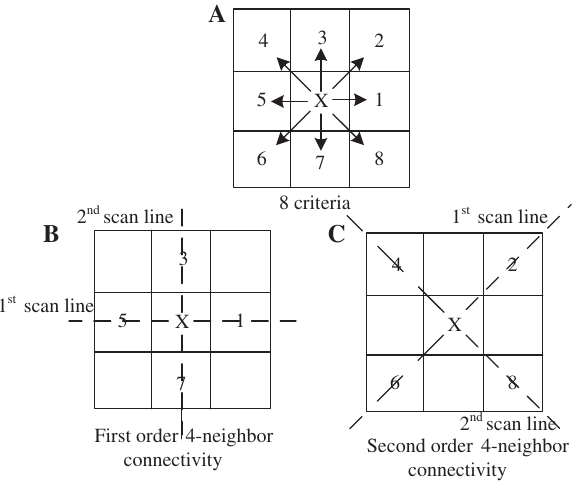
Figure 1. 3 × 3 Pixel Neighborhoods.